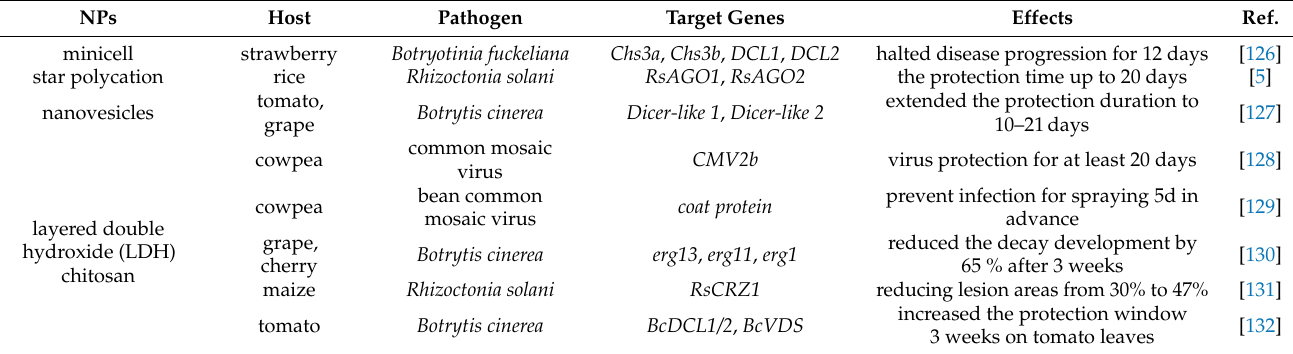
Table 2. Applications of NPs-mediated RNA pesticides for plant disease